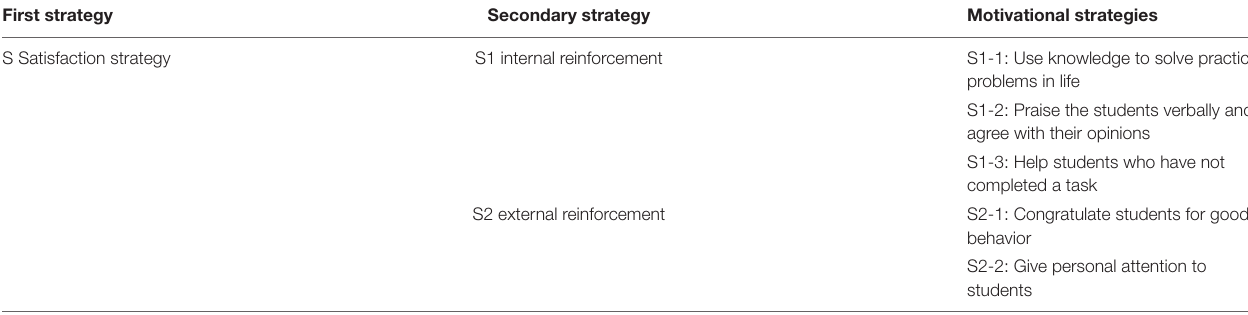
TABLE 4 | Satisfaction strategy coding system after